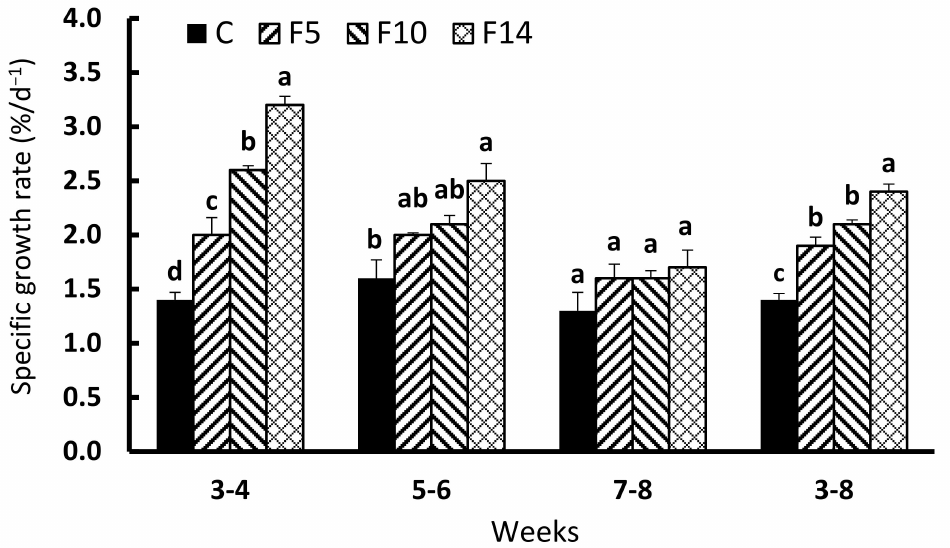
Figure 2. Changes in specific growth rate of juvenile leopard mandarin fish ( Siniperca scherzeri ) subjected to four feeding regimens across an 8-week trial: Control (C), fish fed continuously; F5, fish fasted for 5 days (days 10–14); F10, fish fasted for 10 days (days 5–14); and, F14, fish fasted for 14 days (days 1–14), prior to all fasted fish being fed to satiation. Values (mean ± standard error, n = 3) in the same column with dissimilar letters are significantly different ( p <